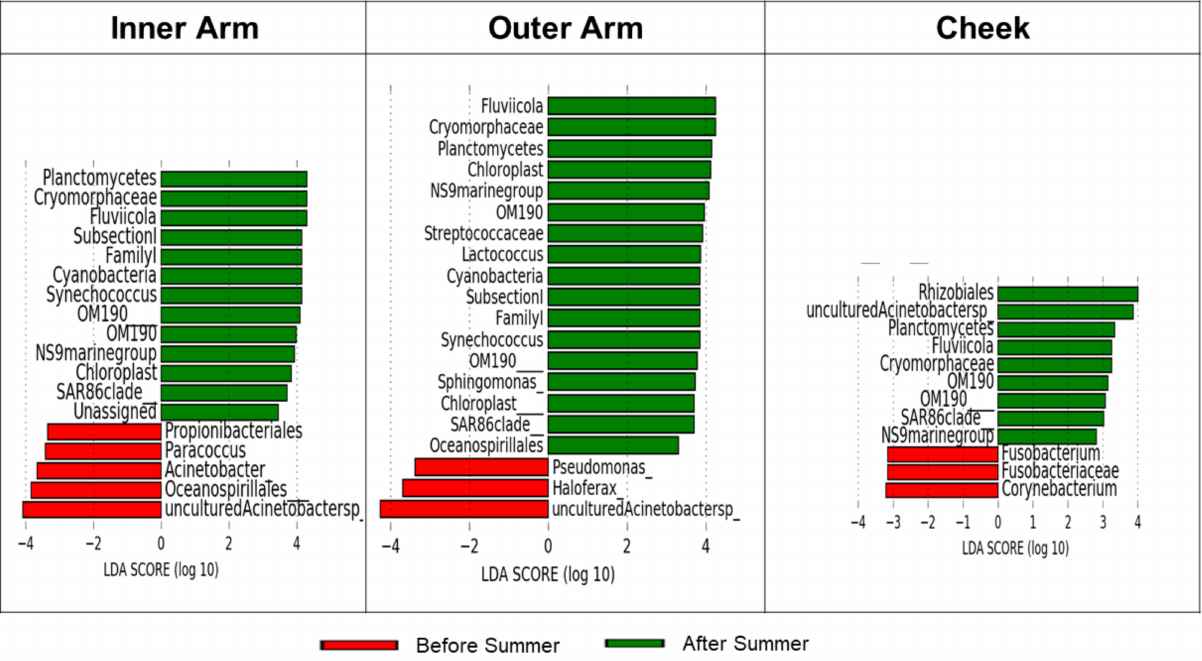
Figure 6. Microbial taxa driving seasonal differences in skin microbiome of lifeguards. Discriminating taxa were identified with LefSe; taxa with prevalence <0.25 were excluded from the